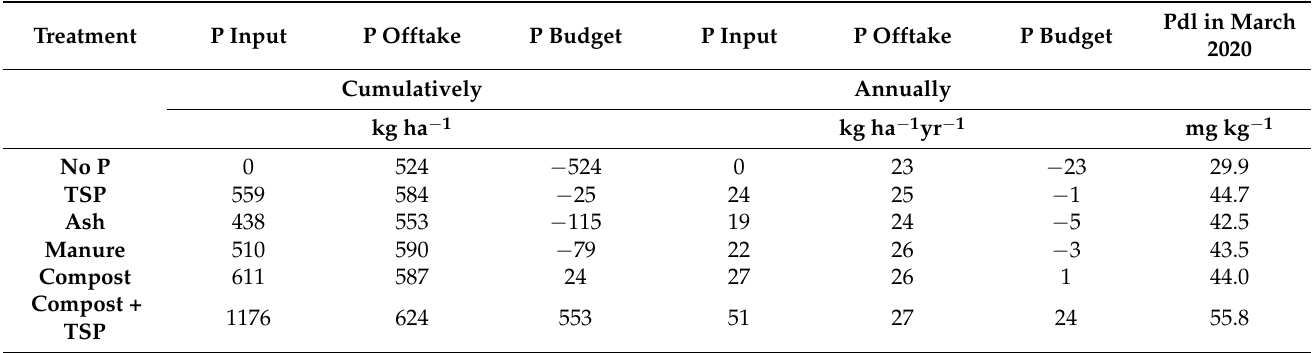
Table 2. Phosphorus (P) input, P offtake, and P budget from 1998 to 2020 and the double lactate extractable P (Pdl) measured in early March 2020 of the six studied